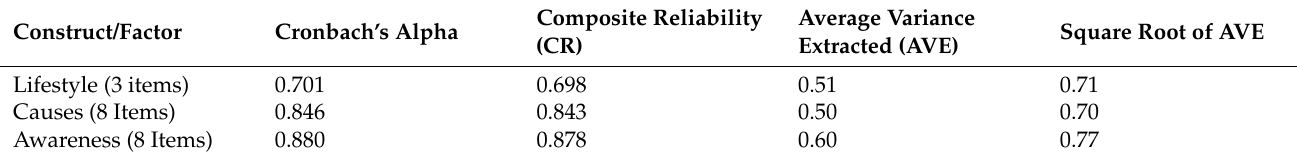
Table A2. Reliability and Convergent Validity